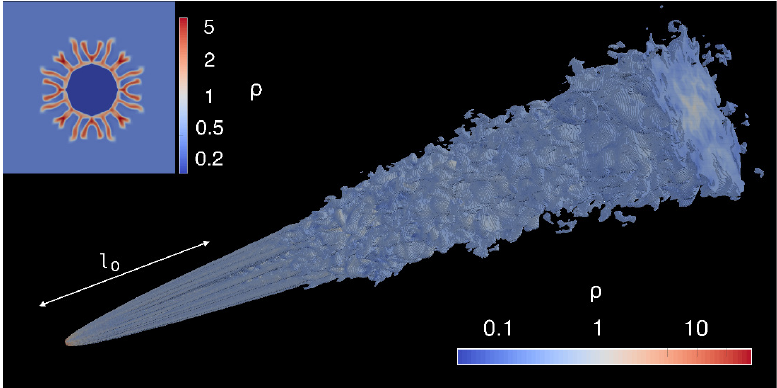
Figure 3. Rest-mass density contour (in arbitrary units) from a simulation in which the development of RTI produces the decollimation and deceleration of a relativistic jet [108] (courtesy of Konstantinos